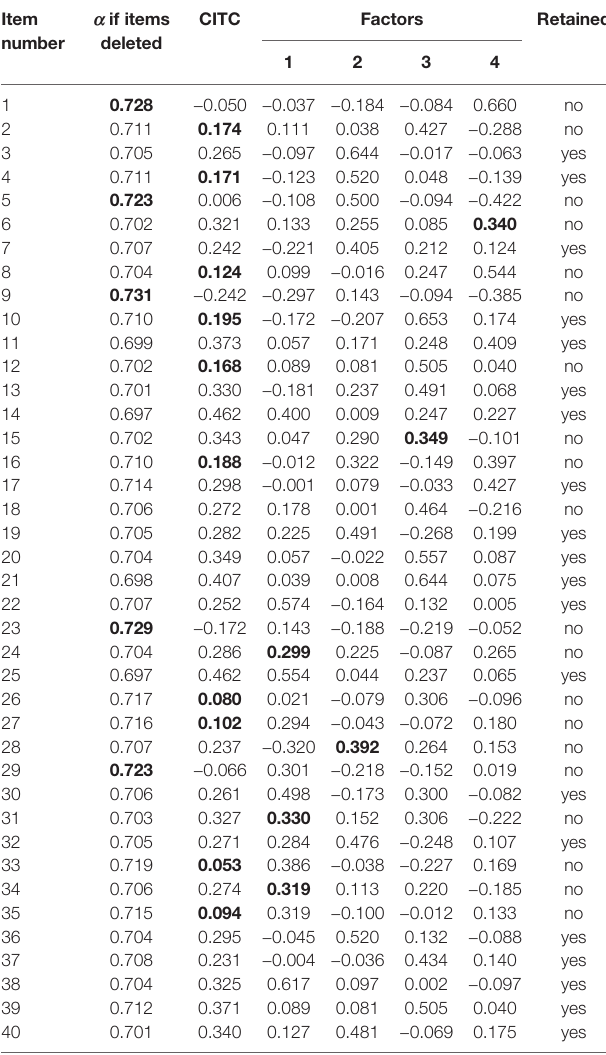
TABLE 1 | The summary of exploratory factor analysis and correlation